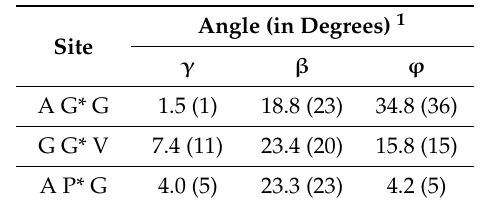
Table 3. The comparison of calculated and single-crystal (SC) solid-state NMR (SSNMR) (taken from reference [14] and shown in parentheses) angles describing an orientation of the 15 N amid chemical shielding / shift tensor of the central residue (marked with an asterisk) in the peptide’s crystal frame. Designation of angles is the same as in reference [14] and should not be confused with the angles used in this